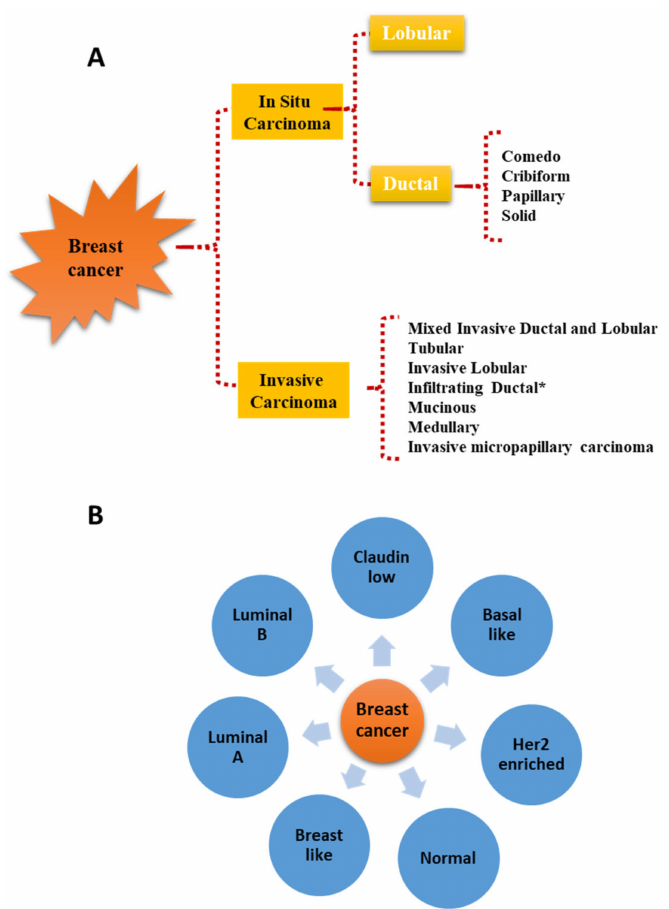
Figure 1. Histological ( A ) and molecular ( B ) classification of breast cancer. * Infiltrating ductal carcinomas evaluated on the basis of nuclear morphology, glandular/tubule formation, and mi- totic index are further sub-classified in well-differentiated, moderately differentiated, and poorly differentiated